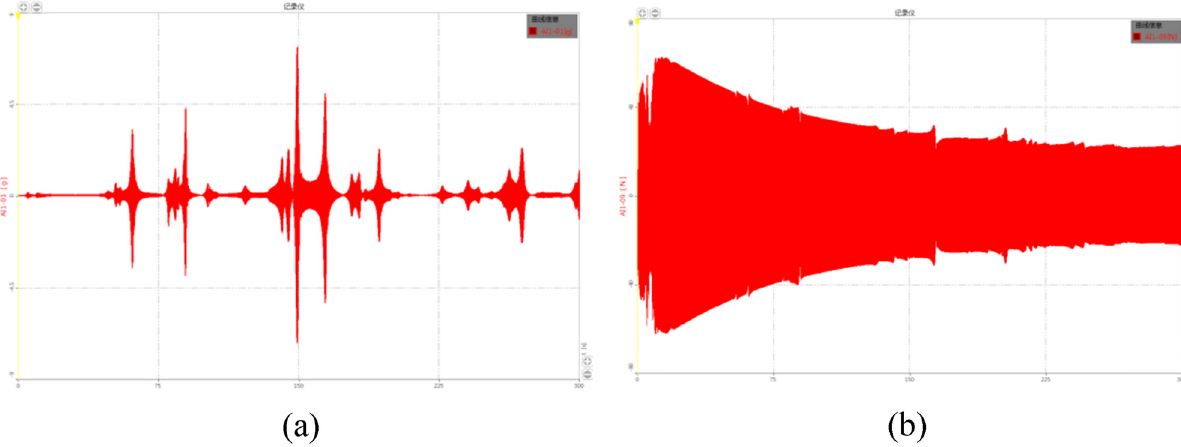
Figure 6: Time history signal curve: ( a ) acceleration time history signal of channel #1; ( b ) excitation force time history signal of channel